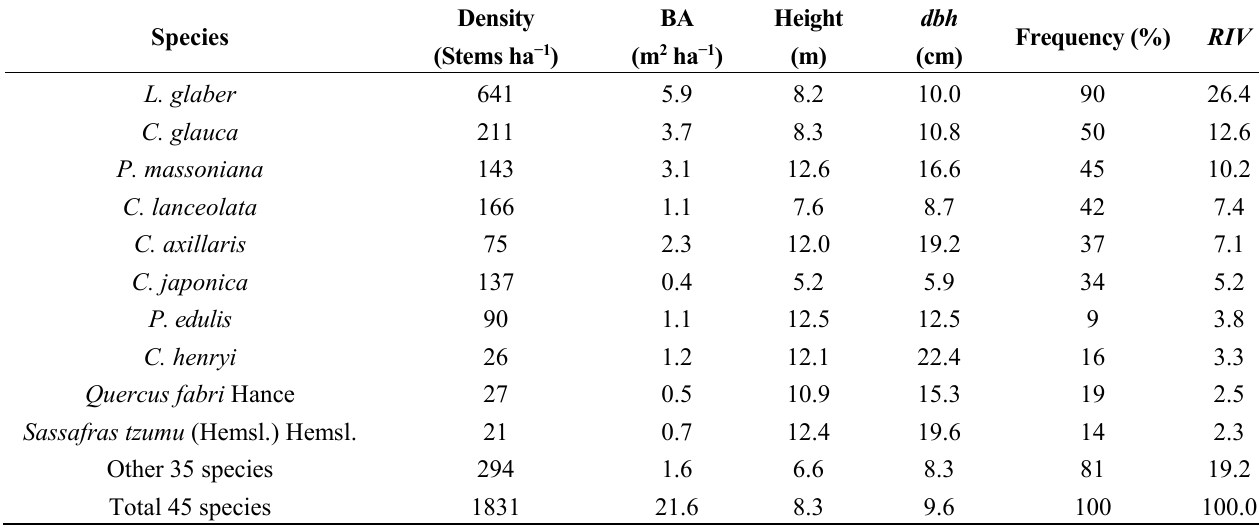
Table 2. Density, basal area (BA), height, average diameter at breast height ( dbh ), frequency, and relative important value ( RIV ) of ten dominant species with dbh ≥ 4 cm in a 1 ha evergreen broadleaved forest in